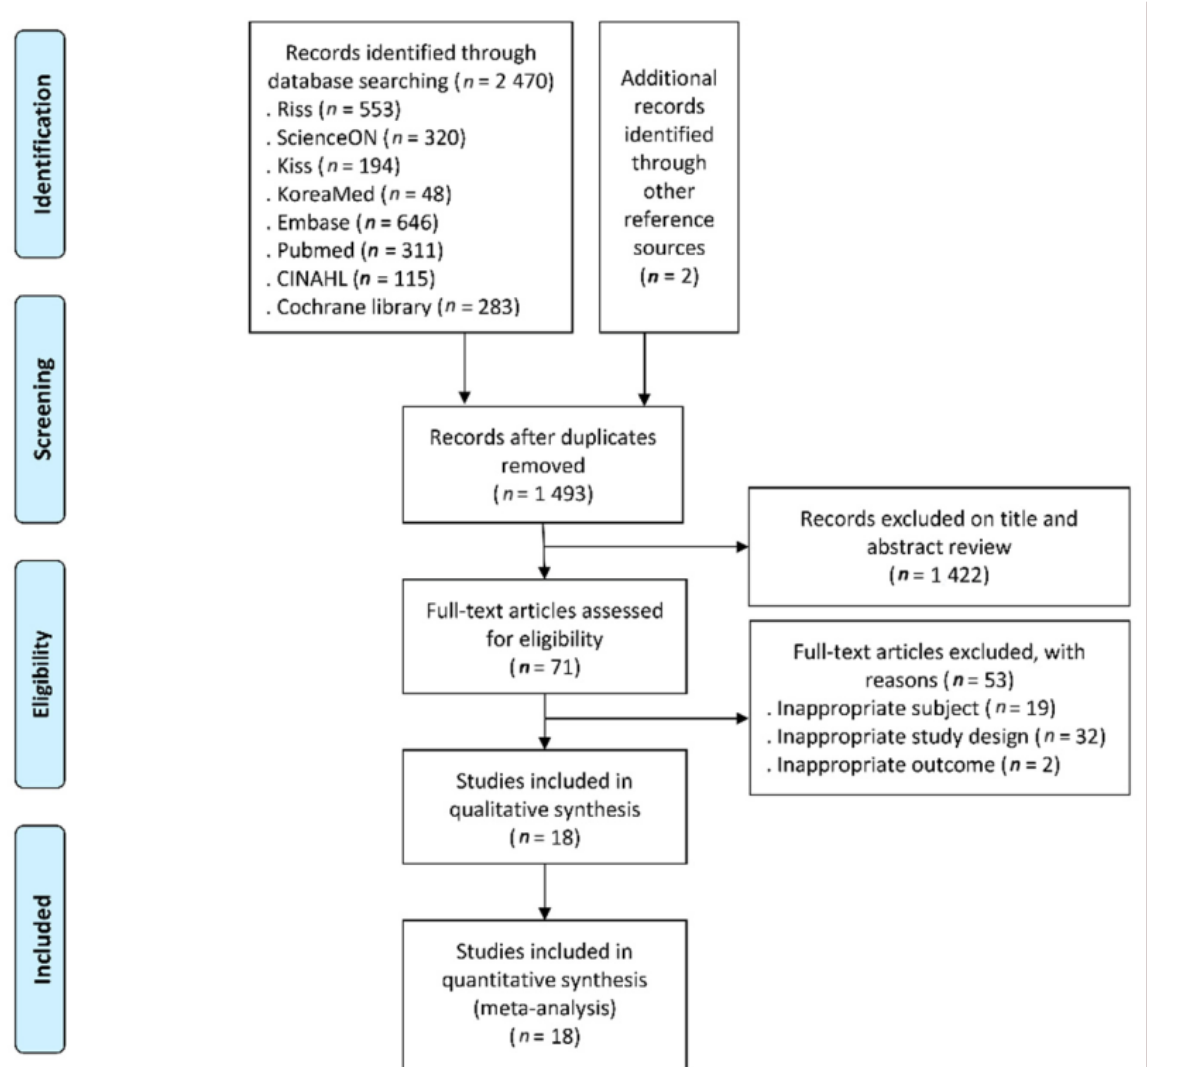
Figure 2. Flow diagram of study